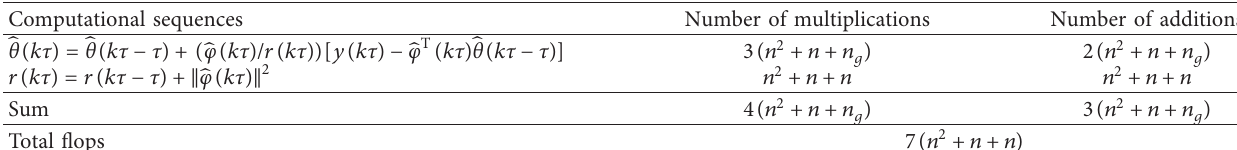
Table 2: The computational efficiency of the SG algorithm.